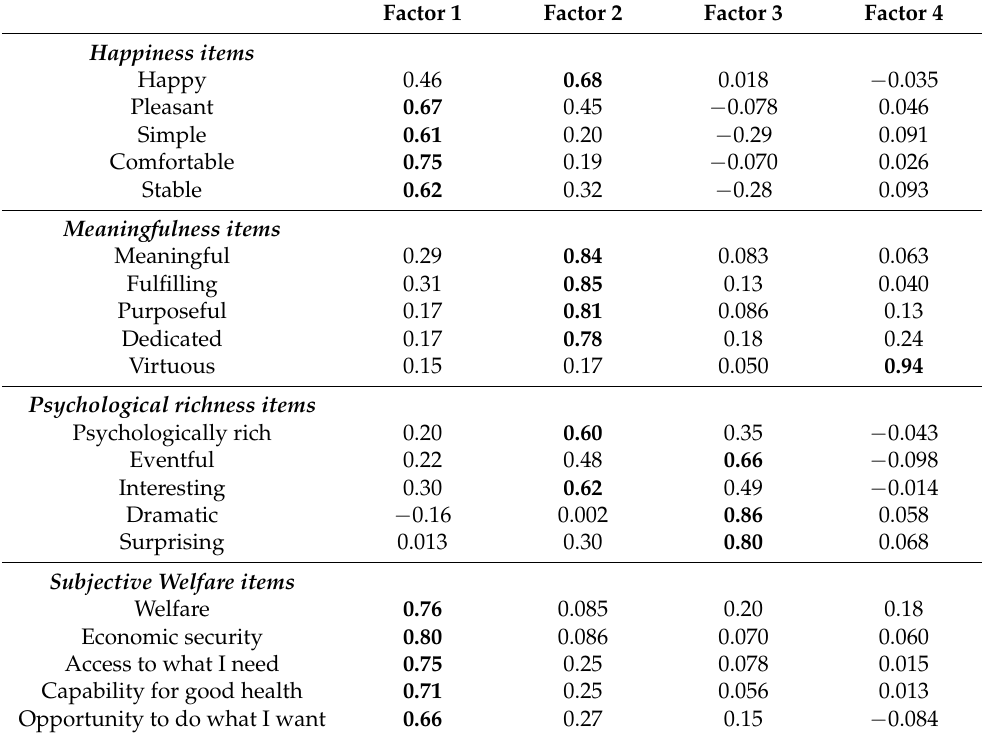
Table 2. Factor loadings for the three wellbeing dimensions and subjective welfare.